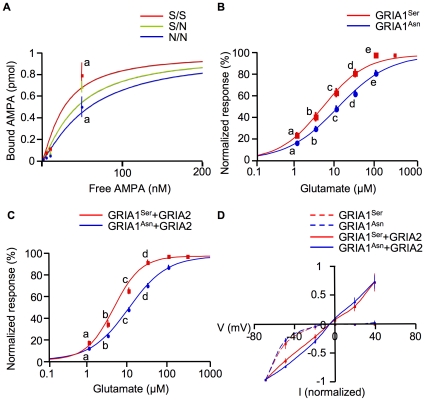
S306N in GRIA1 affects ligand affinity.(A) Saturation curves for [3H] AMPA binding to brain of S/S (red, n = 3), S/N (green, n = 3), and N/N cows (blue, n = 3). Data are presented as mean ± SEM. a indicates p<0.05 by Student's t-test between S/S and N/N cows. (B) Dose-response curves of Xenopus oocytes expressing GRIA1Ser (red, n = 10) or GRIA1Asn (blue, n = 9). Normalized response means current normalized to the current evoked by a saturating dose of glutamate. Data are presented as mean ± SEM. a–e indicate p<0.05 by Student's t-test between GRIA1Ser and GRIA1Asn. (C) Dose-response curves of Xenopus oocytes expressing GRIA1Ser (red, n = 8) or GRIA1Asn (blue, n = 8) with GRIA2. Data are presented as mean ± SEM. a–d indicate p<0.05 by Student's t-test between GRIA1Ser and GRIA1Asn. (D) I–V relationships of oocytes expressing GRIA1Ser (red broken line; n = 4), GRIA1Ser with GRIA2 (red line; n = 5), GRIA1Asn (blue broken line; n = 4), and GRIA1Asn with GRIA2 (blue line; n = 5). Each I–V relationship was normalized to the current obtained at −70 mV. Data are presented as mean ± SEM.